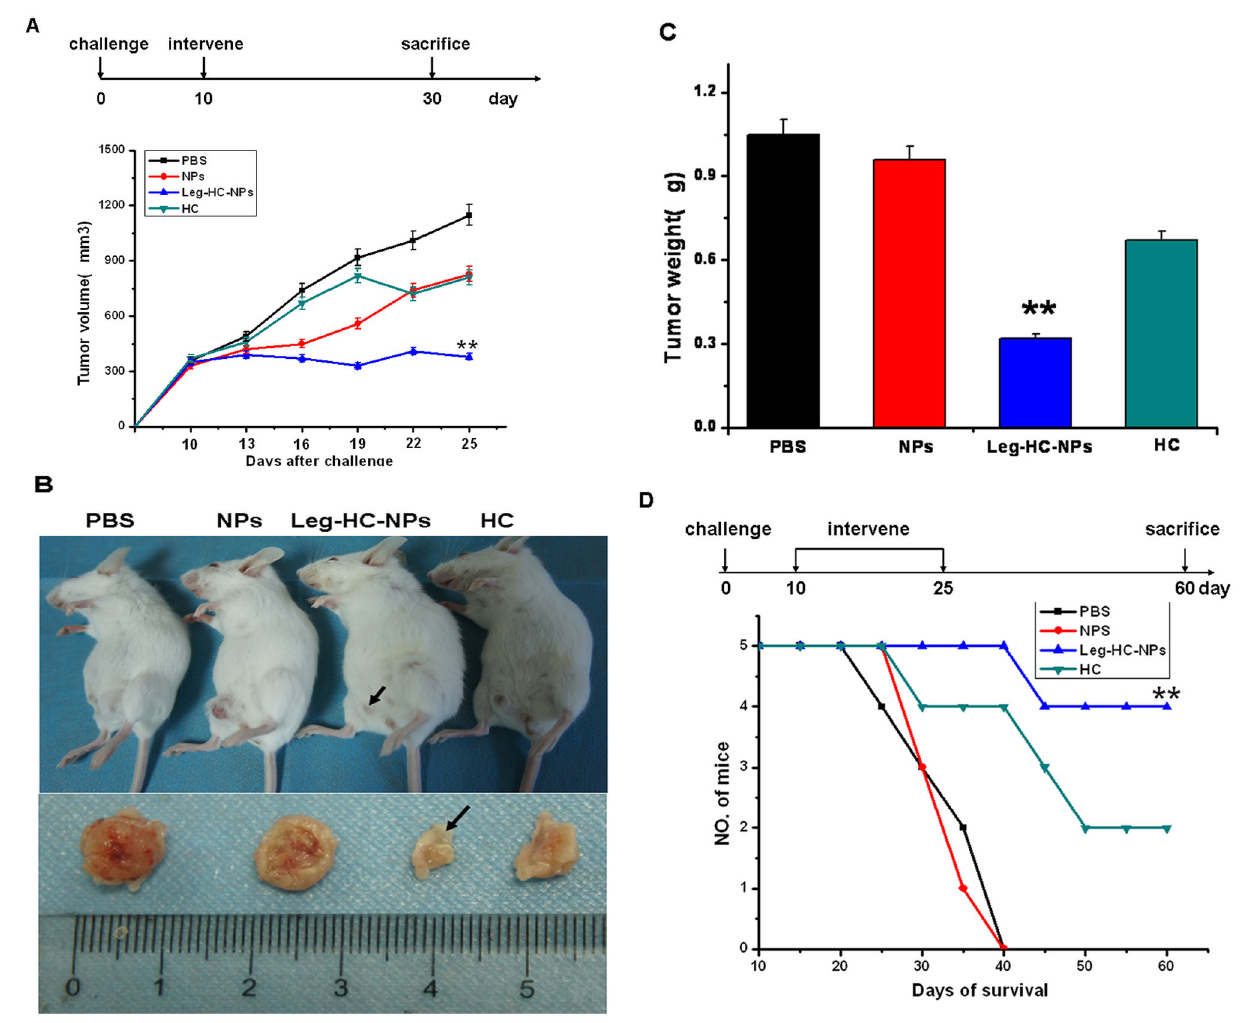
Figure 4. Legumain-targeting HC-NPs inhibited breast tumor growth and prolonged tumor-bearing mice survival time when 4T1 co-injected with RAW264.7 into mice fat pad. Groups of female BABLB/C mice (n = 5) were co-injected with 1×10 6 4T1 tumor cells and 1×10 6 E-RAW264.7 cells in the mammary fat pad and 10 days later, give 5 IV injections on days 10, 13, 16, 19, 22, 25 with PBS, NPs, Legumain-targeting HC-NPs (Leg-HC-NPs) and free HC respectively. (A) Tumor volume after treatment with Leg-HC-NPs, HC or controls (PBS or NPs). (B) The difference in tumor size at day 30 after 5 doses of treatment when mice were sacrificed. (C) The measurement of primary tumor wet weight. (D) The difference of survival time between Leg-HC-NPs treatment and control groups, survival plots stood for 5 mice in each group. doi: